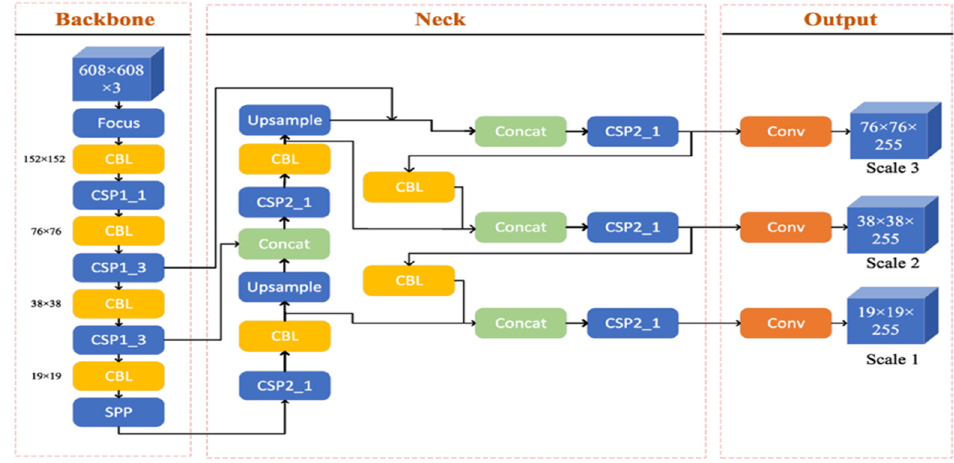
Figure 3. YOLOv5 architecture as displayed in [55].